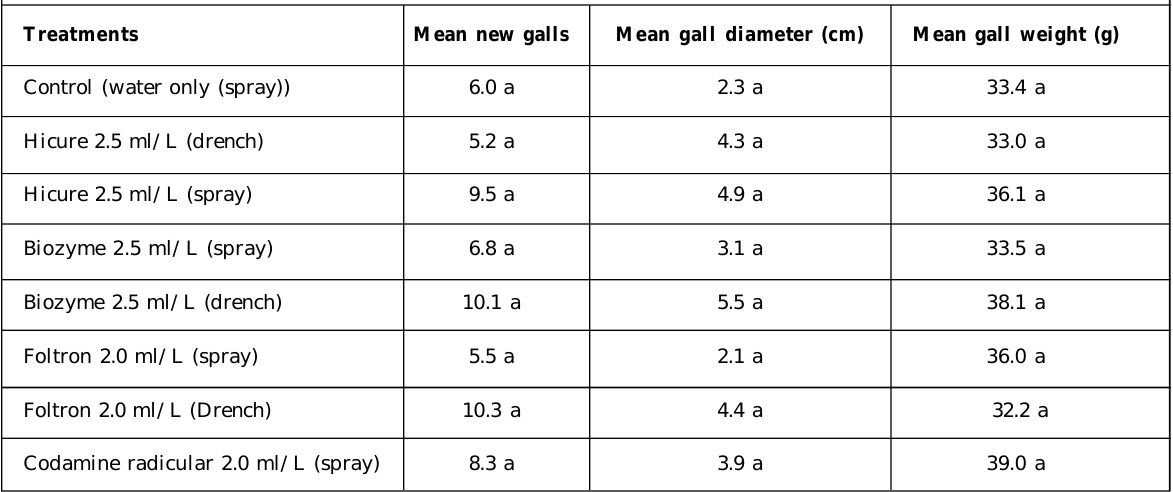
Table 5: Mean new alls gall diameter and gall weight on plots treated with hicure 2.5 ml/L, biozyme 2.5 ml/L, with water only (pooled data for one year pot experiment)